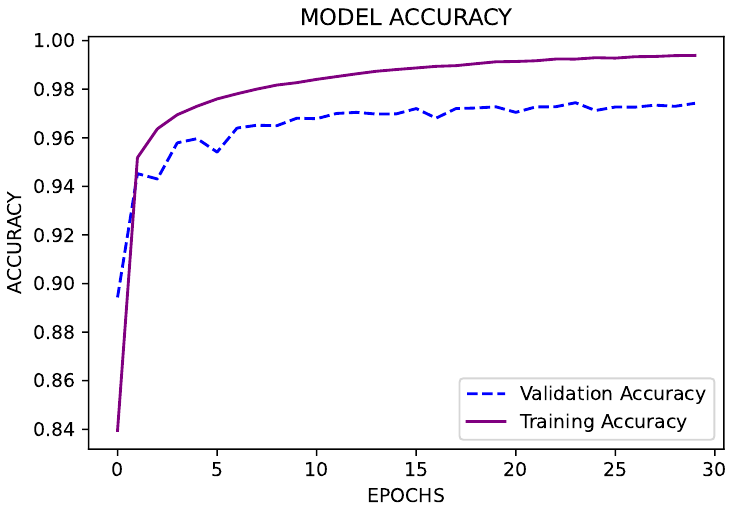
Figure 15. Validation accuracy for blood pressure